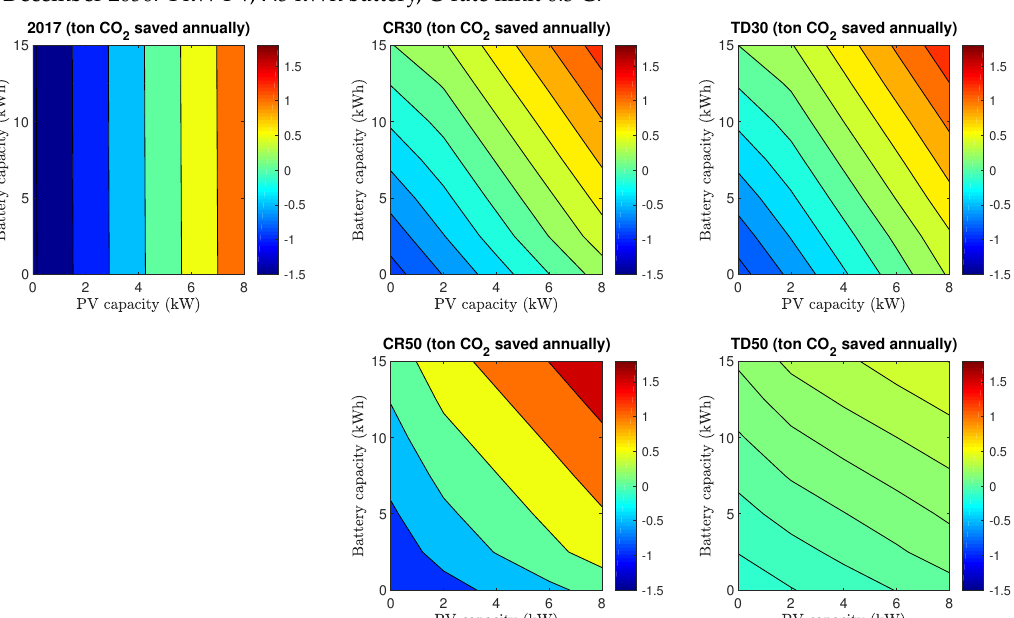
Figure 8. MEF ( t ) in Community Renewables scenario, for ( a ) 21–28 May 2050, and ( b ) 25 November–2 December 2050. 4 kW PV, 7.5 kWh battery, C-rate limit 0.3 C.